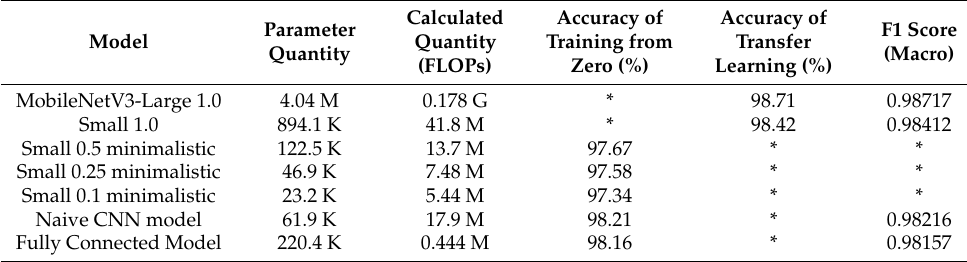
Table 4. Performance of the optimized model.